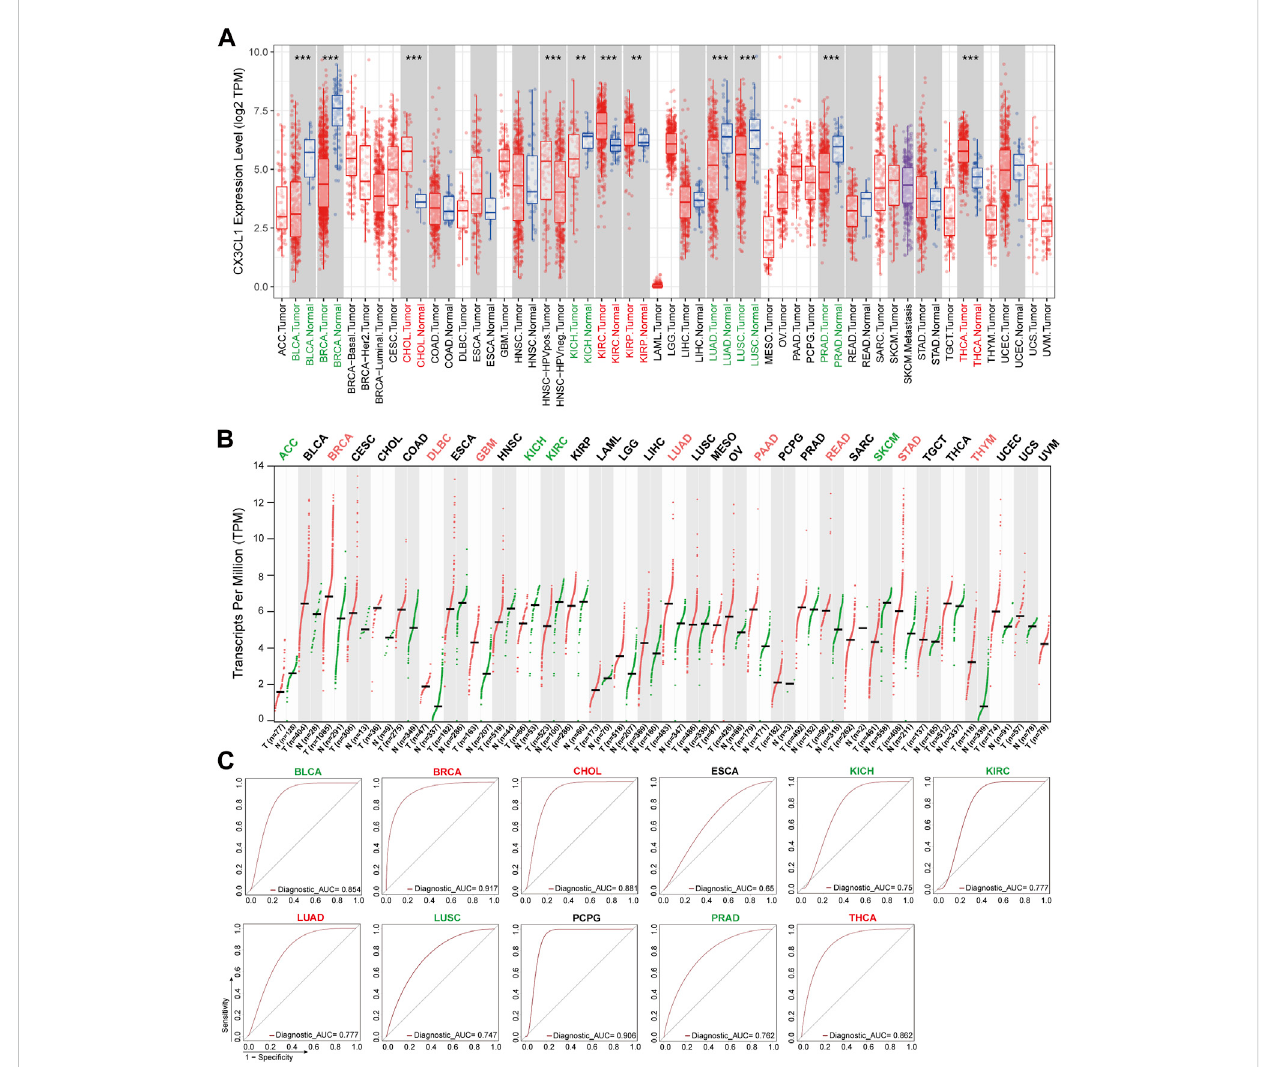
FIGURE 1 Aberrant expression of CX3CL1 across TCGA cancer types. (A) The TIMER2 database showed differential expression of CX3CL1 between various tumor tissues (red) and normal tissues (blue) in adrenocortical carcinoma (ACC), bladder urothelial carcinoma (BLCA), breast invasive carcinoma (BRCA), cervical squamous cell carcinoma and endocervical adenocarcinoma (CESC), cholangiocarcinoma (CHOL), colon adenocarcinoma (COAD), lymphoid neoplasm diffuse large B-cell lymphoma (DLBC), esophageal carcinoma (ESCA), glioblastoma multiforme (GBM), head and neck squamous cell carcinoma (HNSC), kidney chromophobe (KICH), kidney renal clear cell carcinoma (KIRC), kidney renal papillary cell carcinoma (KIRP), acute myeloid leukemia (LAML), brain lower grade glioma (LGG), liver hepatocellular carcinoma (LIHC), lung adenocarcinoma (LUAD), lung squamous cell carcinoma (LUSC), mesothelioma (MESO), ovarian serous cystadenocarcinoma (OV), pancreatic adenocarcinoma (PAAD), pheochromocytoma and paraganglioma (PCPG), prostate adenocarcinoma (PRAD), rectum adenocarcinoma (READ), sarcoma (SARC), skin cutaneous melanoma (SKCM), stomach adenocarcinoma (STAD), testicular germ cell tumors (TGCT), thyroid carcinoma (THCA), thymoma (THYM), uterine corpus endometrial carcinoma (UCEC), uterine carcinosarcoma (UCS), uveal melanoma (UVM). ** p < 0.01; *** p < 0.001. (B) The GEPIA2 database showed differential expression of CX3CL1invarioustumortissues(red)vs.normaltissues(green)basedonTheCancerGenomeAtlas(TCGA)andGenotype-TissueExpression(GTEx)data. (C) Receiver operating characteristic (ROC) curves of different cancer